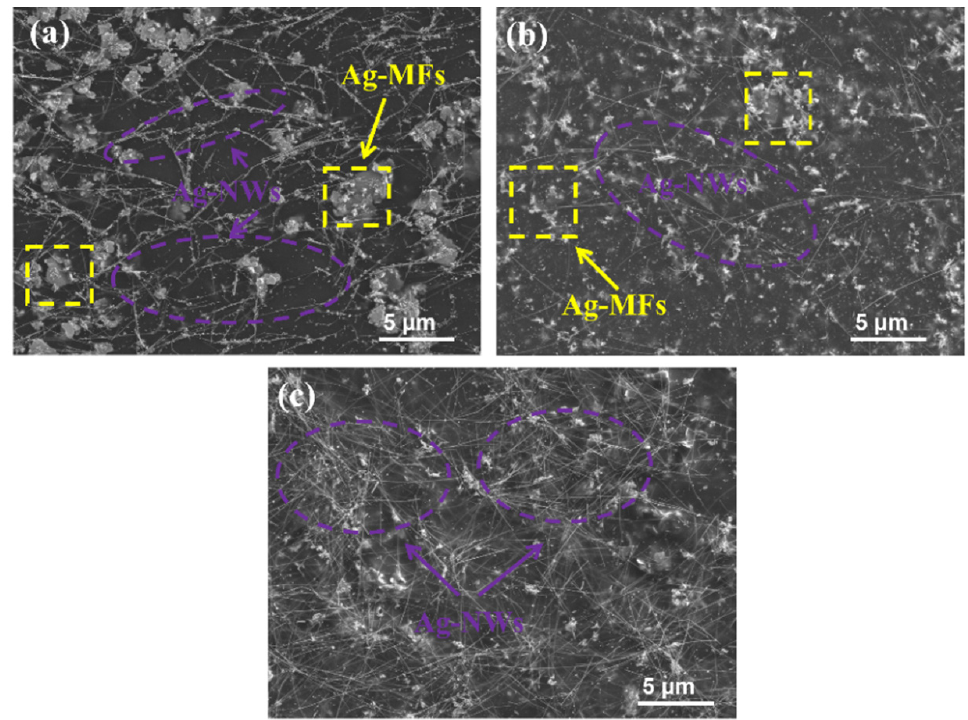
Figure 7. SEM images of silver paste paint films containing different amounts of Ag MFs, Ag NWs, and Ag NPs after curing at 60 °C : ( a ) F 20.0 P 7.5 W 2.5 , ( b ) F 20.0 P 5.0 W 5.0 , and ( c ) F 20.0 P 2.5 W 7.5. Table 4. Hardness and adhesive strength of silver paste paint films containing different amounts of Ag MFs, Ag NWs, and Ag NPs after curing at 60 °C.